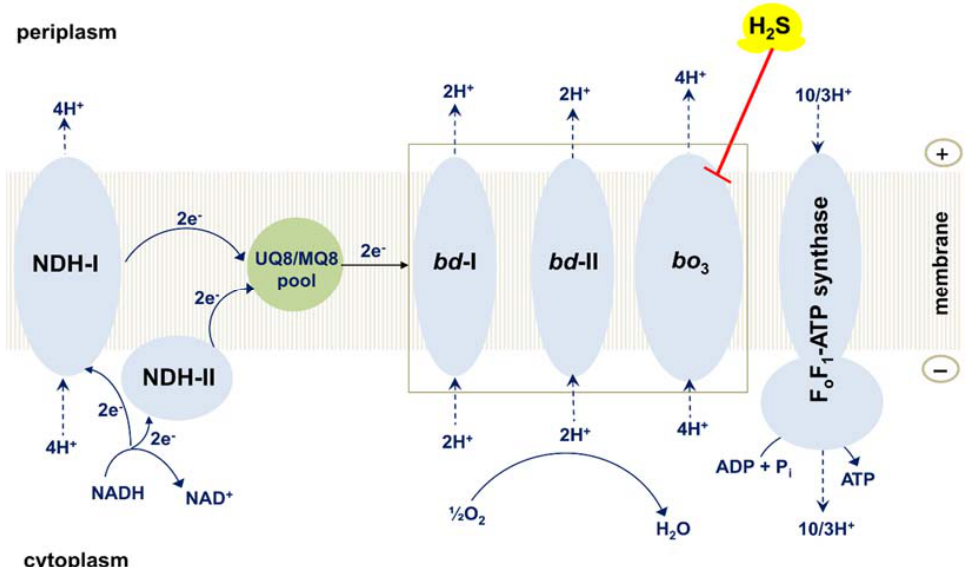
Figure 7. Effect of H 2 S on the operation of the branched respiratory chain of E. coli . Shown is the schematic view of the branched aerobic respiratory chain of E. coli . H 2 S inhibits cytochrome bo 3 but does not affect cytochrome bd -I and cytochrome bd -II. Succinate dehydrogenase and other substrate dehydrogenases are not shown for clarity.